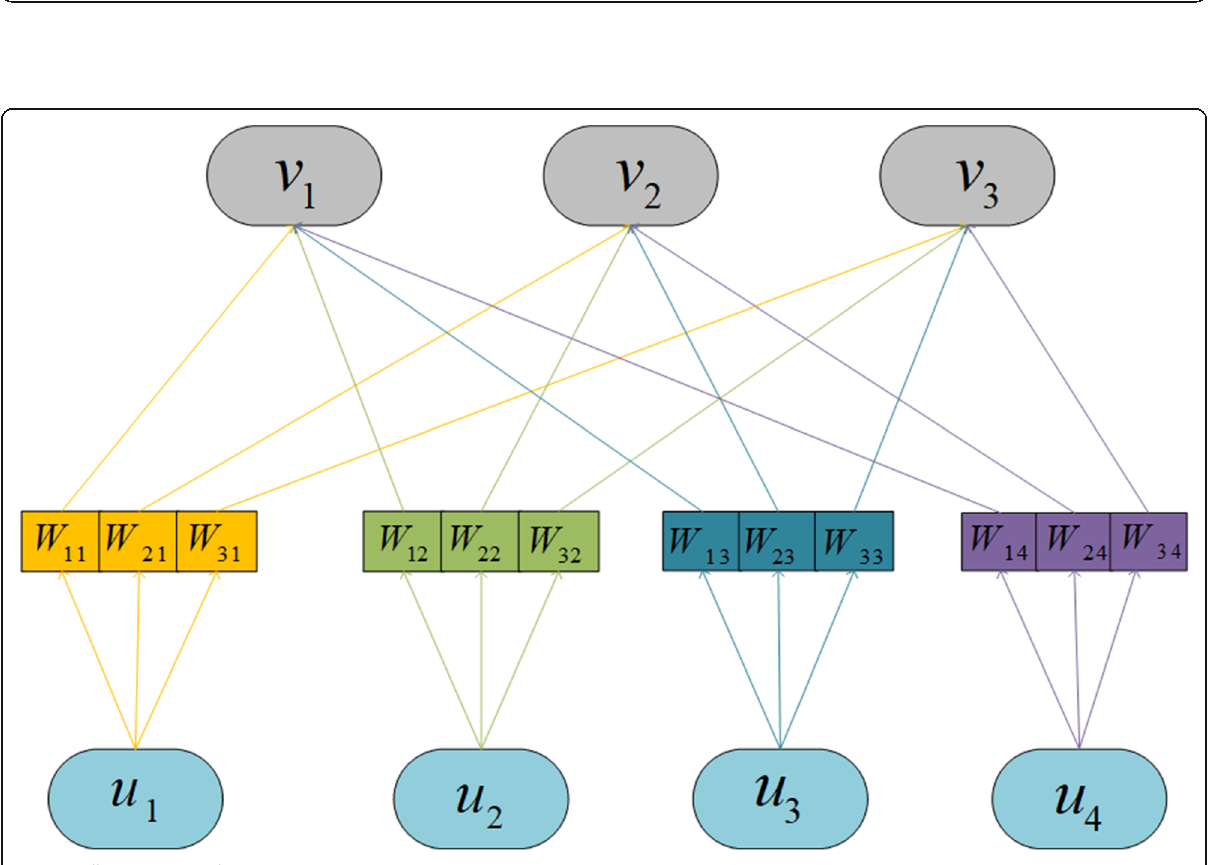
Fig. 3 The parallel convolution layer includes three convolution paths, with each path containing asymmetric kernels of different kernel sizes